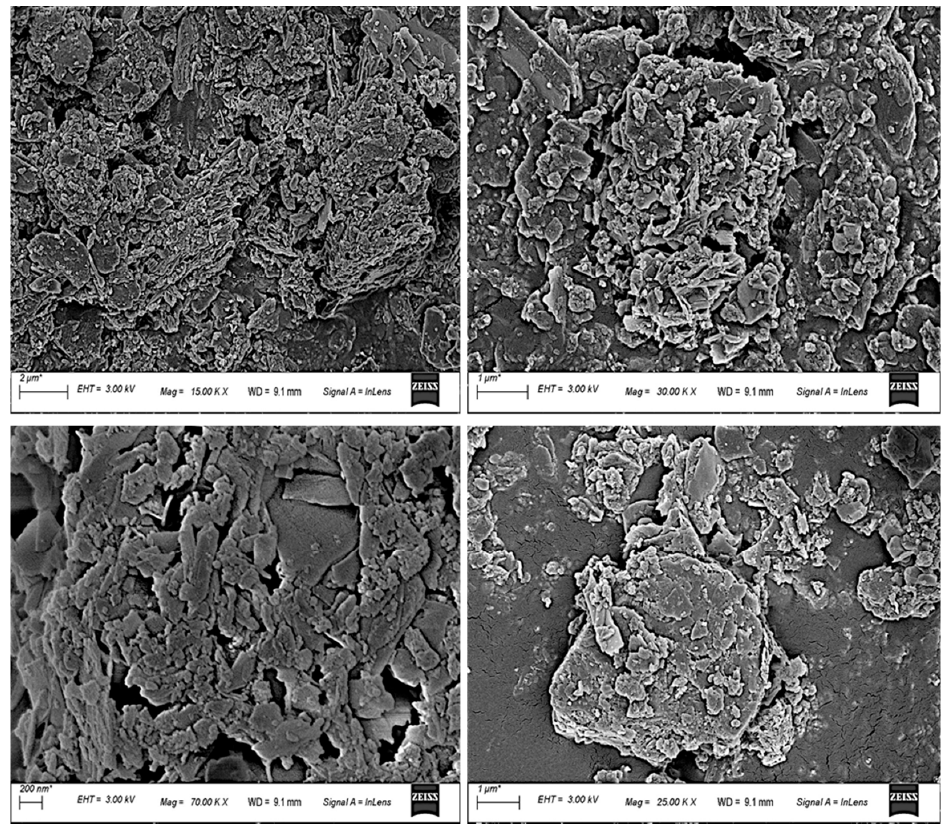
Figure 5. Microstructure morphology of parts of the mixed C&D waste at different magnifications.